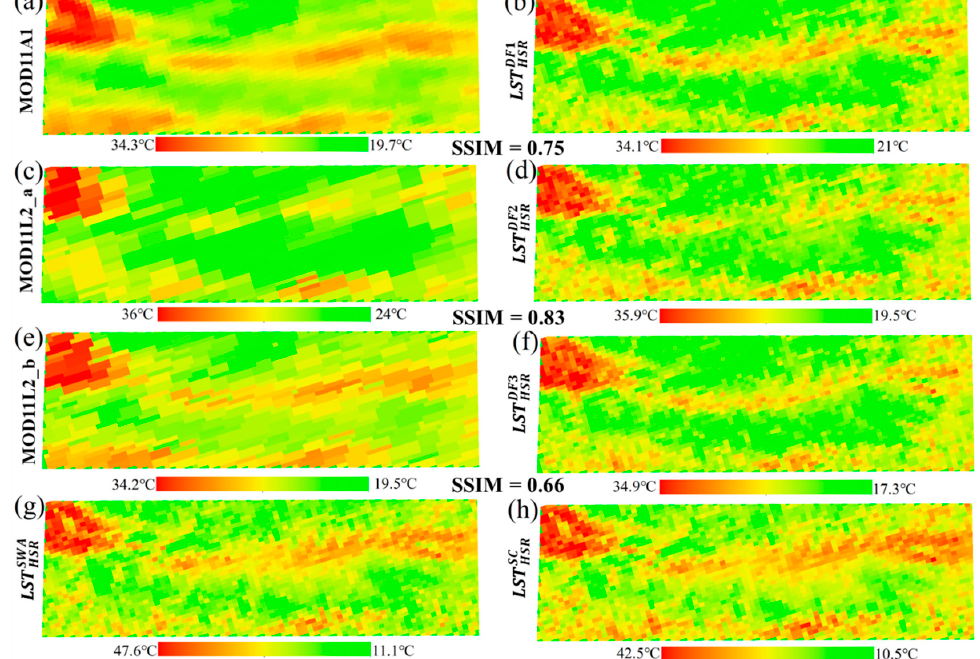
Figure 10. The spatial distributions of the MODIS LSTs ( a,c,e ), HSR fused LSTs ( b,d,f ), and reference LSTs ( g,h ) of Case 2 on 16 July, 2017. The HSR fused LSTs and reference LSTs are resampled to match the spatial resolution of MODIS LST.